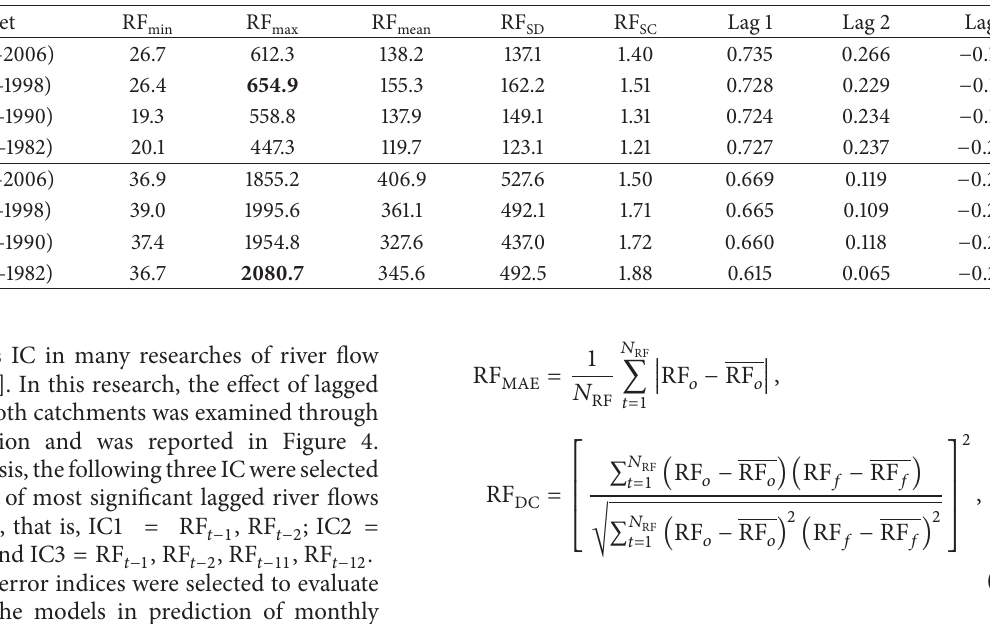
Figure 4: Autocorrelation function of river flow series of (a) Astore catchment and (b) Shyok catchment. Table 1: The monthly statistical parameters of river flow data for Astore and Shyok